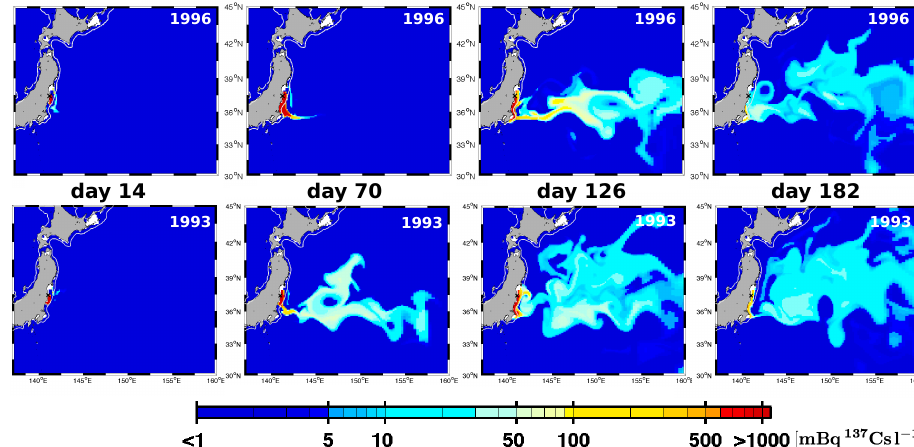
Fig. 10. Simulated surface 137 Cs activities. Shaded in color is that fraction that is effected by the direct land-sea discharge. Background activities present prior to the accident and effects of air–sea deposition are not accounted for. The upper and lower row of panels refer to simulations labeled by nominal years 1996 and 1993, respectively (also indicated in the upper right corner of each panel). The time information centered in each column of panels denote days elapsed since the 137 Cs discharge on 1 April of respective years. The 200m isobath is indicated by white contours.